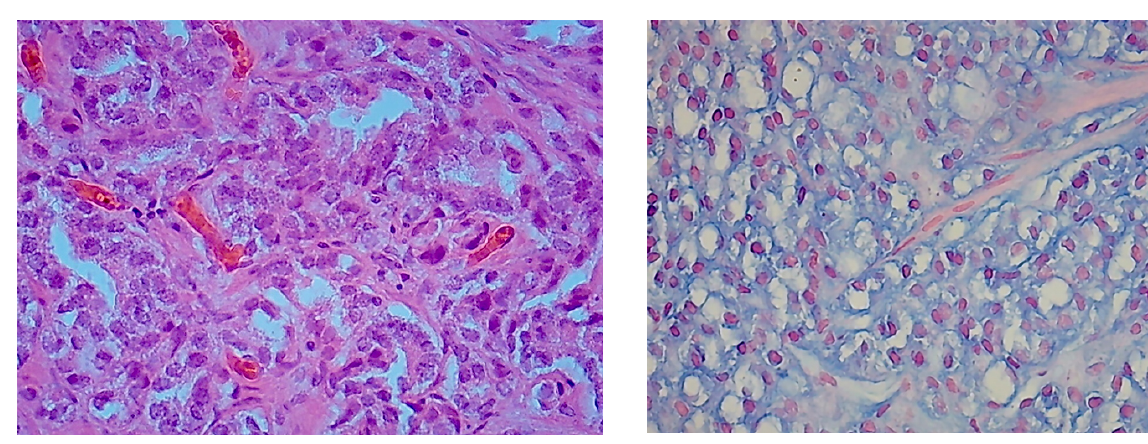
Fig. 2. Conventional adenocarcinoma component, Gleason 4 (hematoxylin and eosin staining, 400 × ).